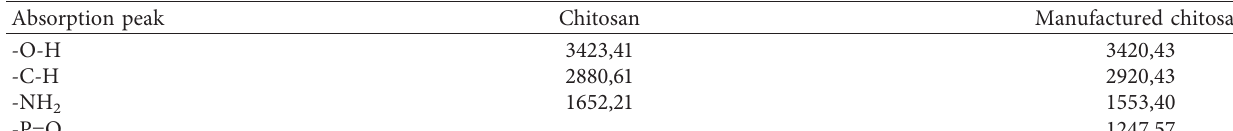
Table. 2: The main absorption peaks (cm − 1 ) of the two substances.